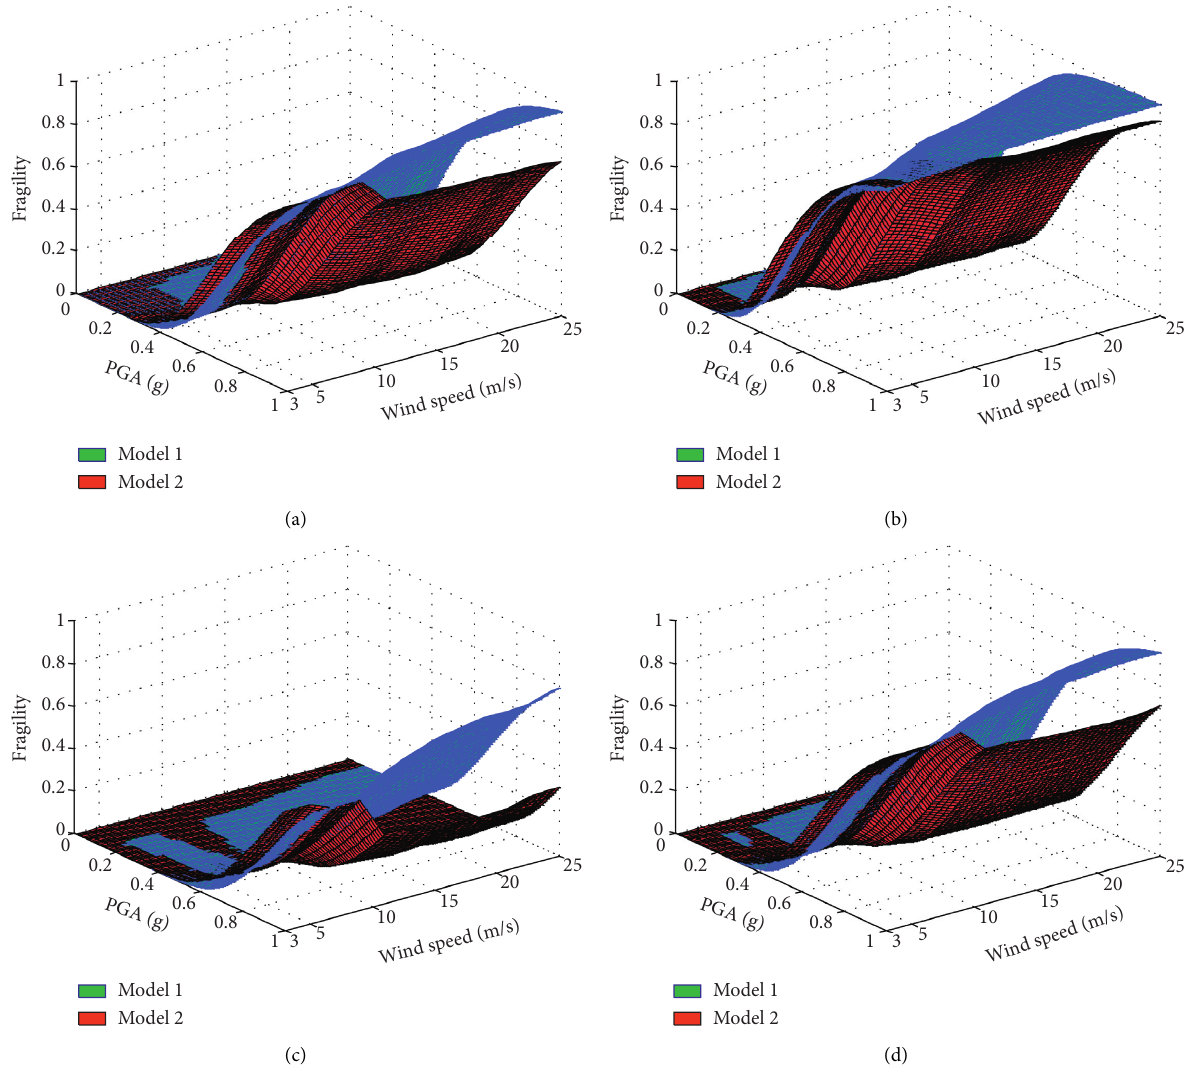
Figure 11: Comparison of the fragility with different wind speeds between the two models: (a) MY, (b) ML, (c) DY, and (d)